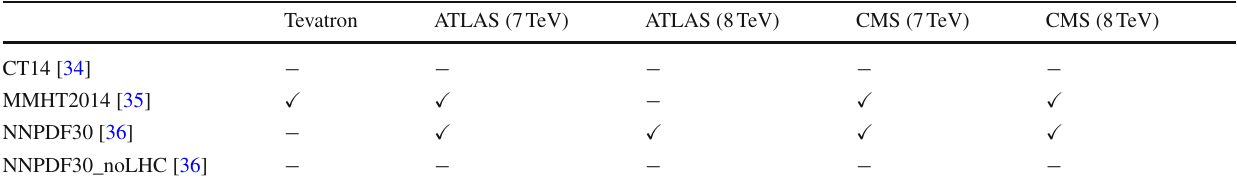
Table 2 Top-pair cross section data included in a selection of recent PDF fits. A “ (cid:2) ” (“ − ”) indicates that the corresponding t ¯ t cross section measurement is (is not) included in the PDF fit. The specific sets of 7